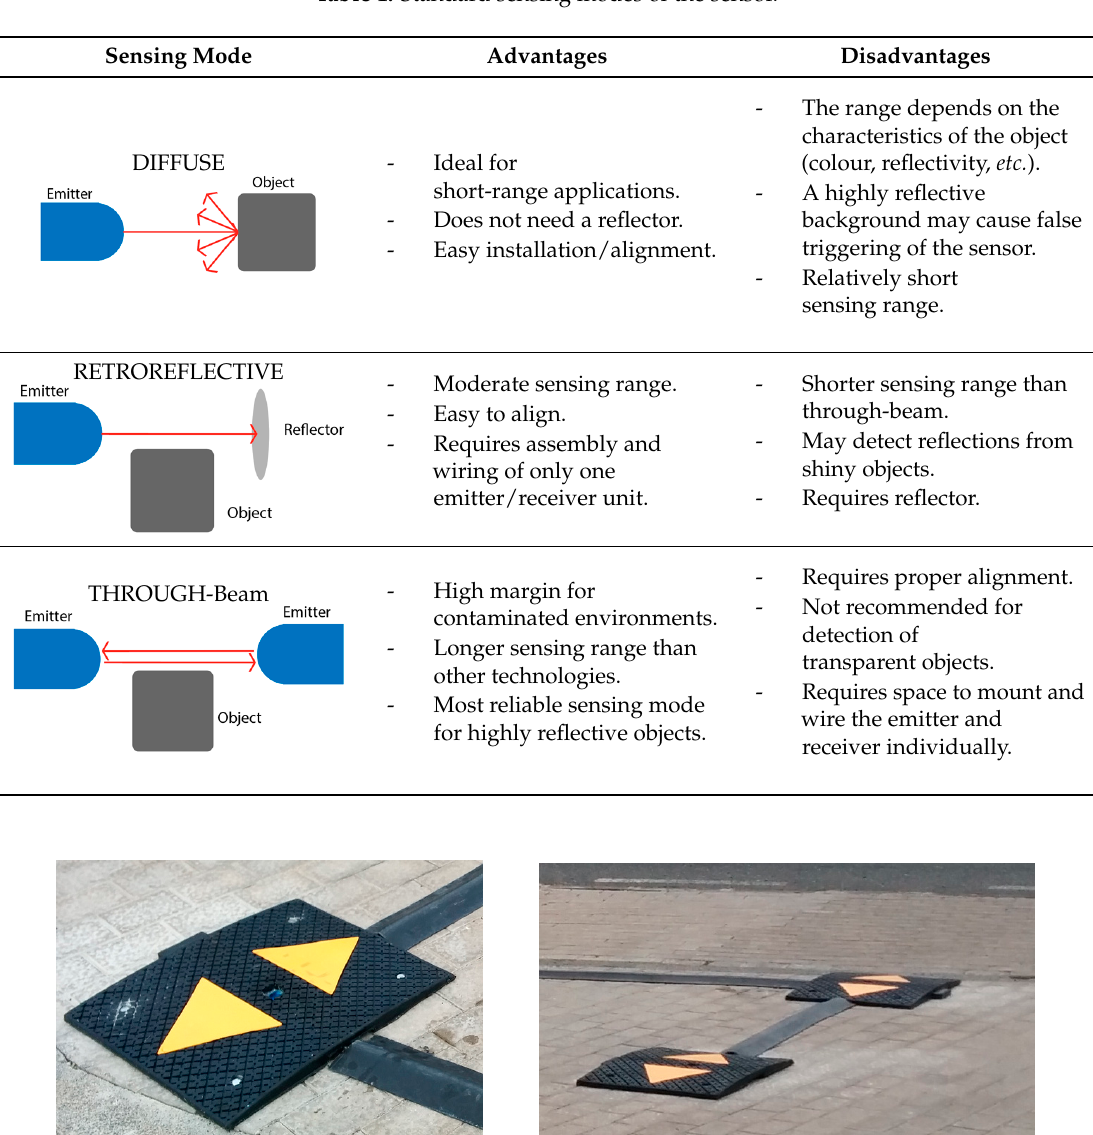
Figure 5. Installation of the sensors in two speed bumps ( left ) photoelectric sensor located at the centre of the speed bump; ( Right ) Pair of speed bumps with the photoelectric sensors.